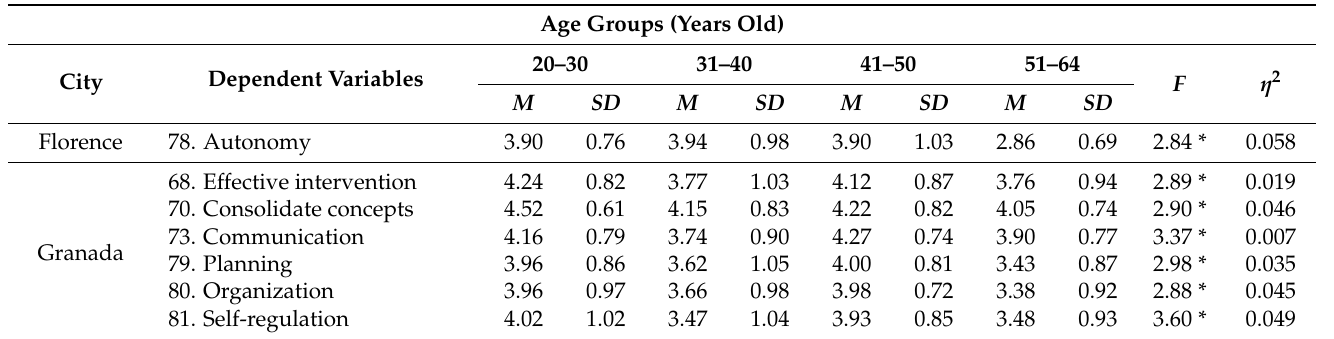
Table 8. Significant differences in the benefits and uses of apps as a function of age. Age Groups (Years Old)